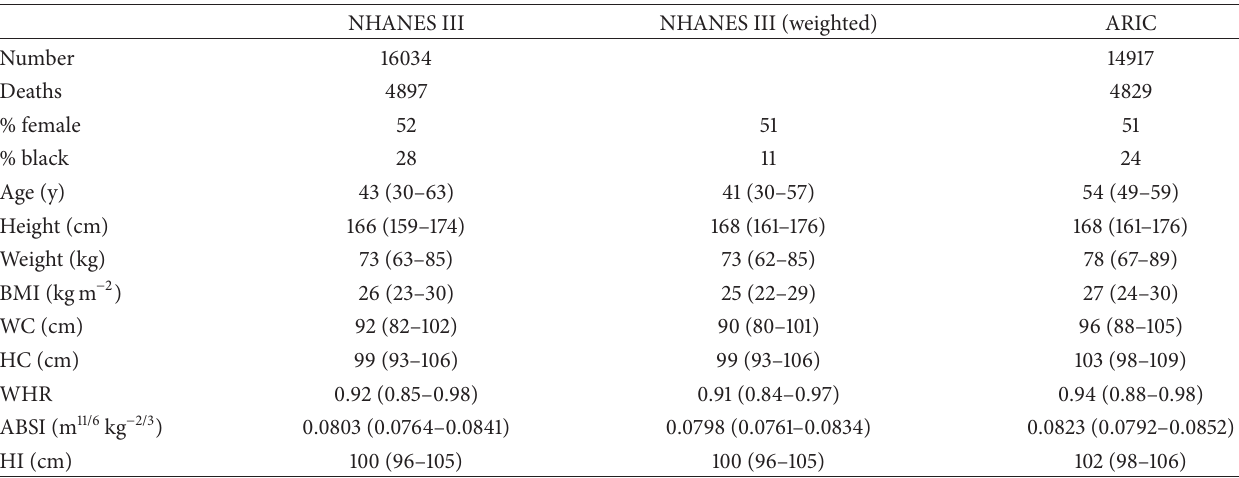
Table 3: NHANES III and ARIC means.